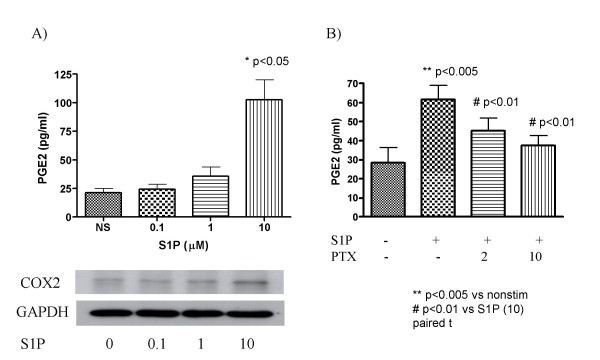
Dose-response and involvement of GPCR in the PGE2 production by S1P. A) Dose-response: OA chondrocytes were stimulated in vitro with S1P (0.1, 1 or 10 μM) for 24 h. Top: Levels of PGE2 in the culture supernatants were assayed using ELISA in triplicate (N = 3 each). Bottom: A representative result of western blot of COX-2 expression is shown. B): PTX inhibition: OA chondrocytes were stimulated in vitro with S1P (10 μM) with or without pertussis toxin (PTX, 10 ng/ml) for 24 h, and levels of PGE2 were analyzed using ELISA (N = 3 each, in triplicate).